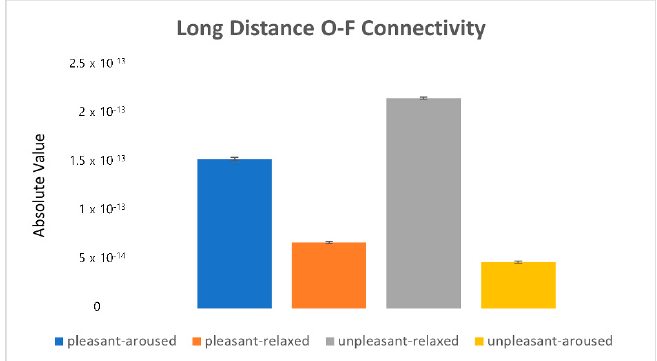
Figure 16. The absolute value in the long-distance O-F connectivity.